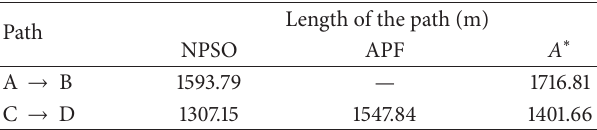
Table 5: Comparison of different algorithms for path